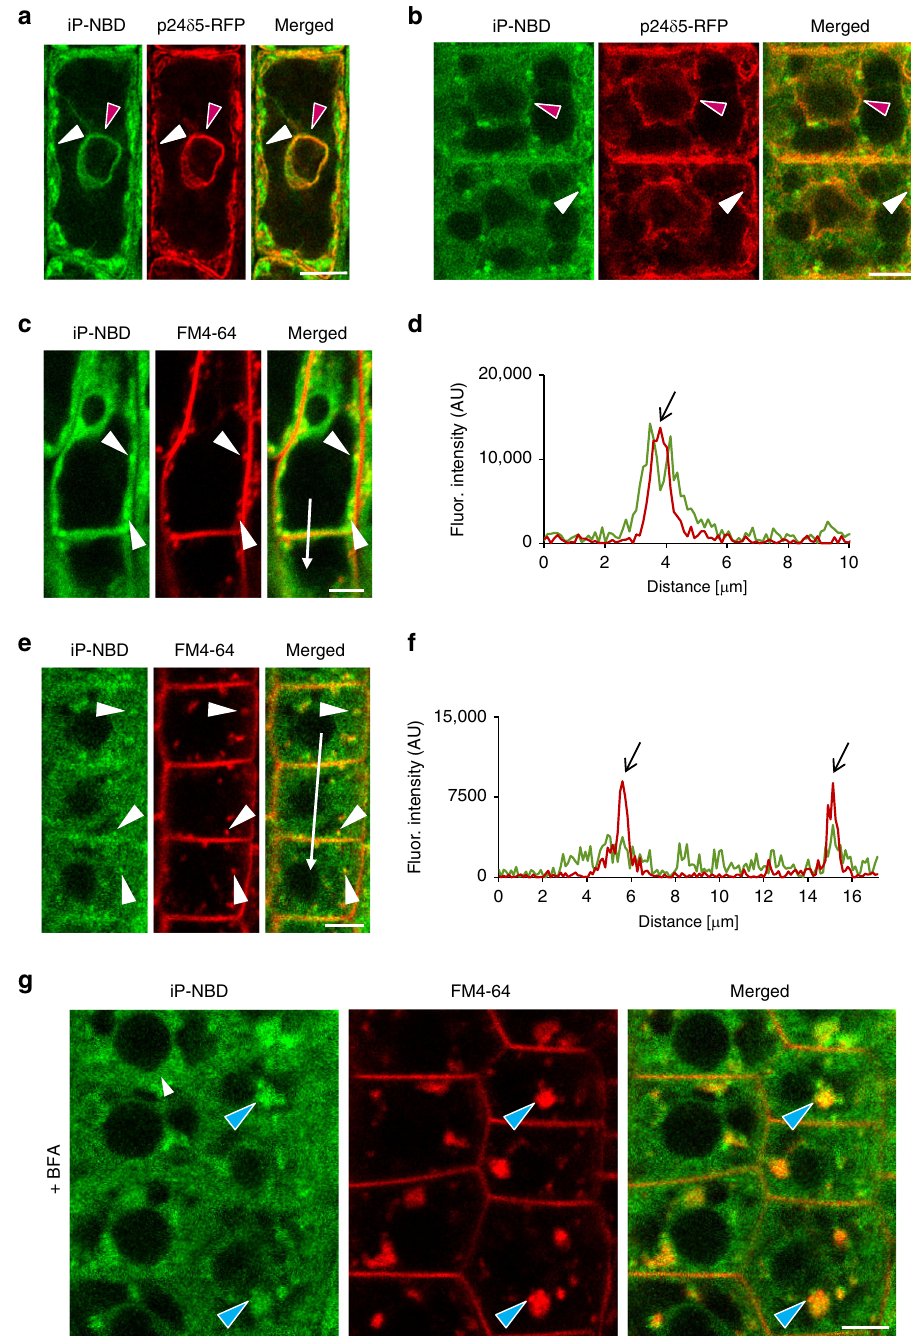
Fig. 2 Monitoring of fl uorescently labelled cytokinin iP-NBD in cells of Arabidopsis root. a , b Monitoring of fl uorescently labelled cytokinin iP-NBD (green) and ER-marker p24 δ 5-RFP (red) in LRC cells ( a ) and root meristematic epidermal cells ( b ). iP-NBD detected partially co-localizing with p24 δ 5-RFP in ER (red arrowheads) and in non-ER cellular structures (white arrowheads). c – f Monitoring of iP-NBD (green) and FM4-64 (red, membrane selective dye) in LRC ( c , d ) and root meristematic epidermal cells ( e , f ). White arrowheads ( c , e ) indicate co-localization of iP-NBD and FM4-64 in vesicles. Pro fi les of fl uorescence intensity distribution of both FM4-64 (red line) and iP-NBD (green line) in LRC ( d ) and epidermal ( f ) cells were measured along the white lines ( c , d ) starting from upper end (0 µ m) towards the arrowhead. Peaks of FM4-64 fl uorescence maxima (black arrows) correlate with the plasma membrane staining. iP-NBD fl uorescence maximum does not overlap with FM4-64 fl uorescence peak at the plasma membrane in LRC cell ( d ). Peaks of iP- NBD signal partially overlap with FM4-64 maxima and indicate presence of cytokinin fl uoroprobe at the plasma membrane of epidermal cells ( f ). g Co- localization of iP-NBD and FM4-64 in endosomal compartments (blue arrowheads) formed in root meristematic epidermal cells treated with 50 µ M in BFA for 1 h. Scale bars = 5 μ